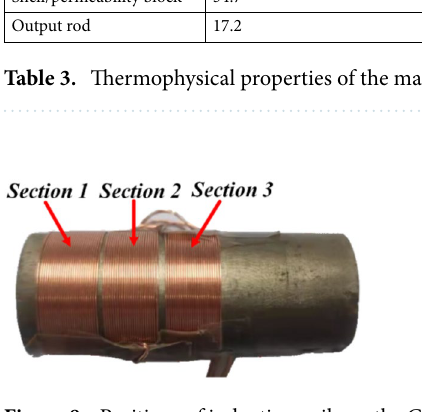
Figure 8. Positions of induction coils on the GMM